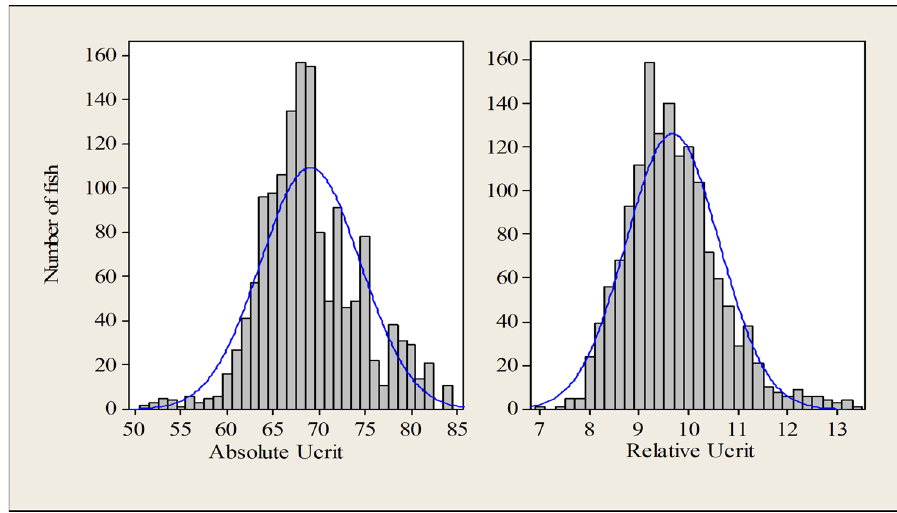
Figure 2. Distribution of absolute U crit (cm s −1 ) and relative U crit (SL s −1 ).